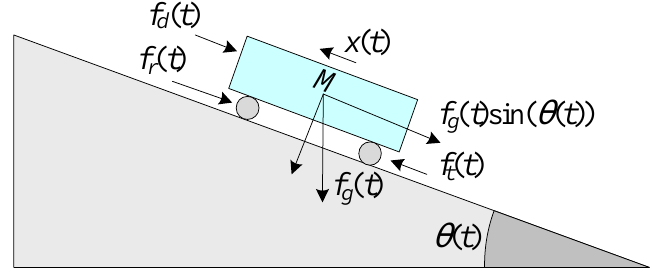
Figure 10. Schematic of the longitudinal vehicle model.